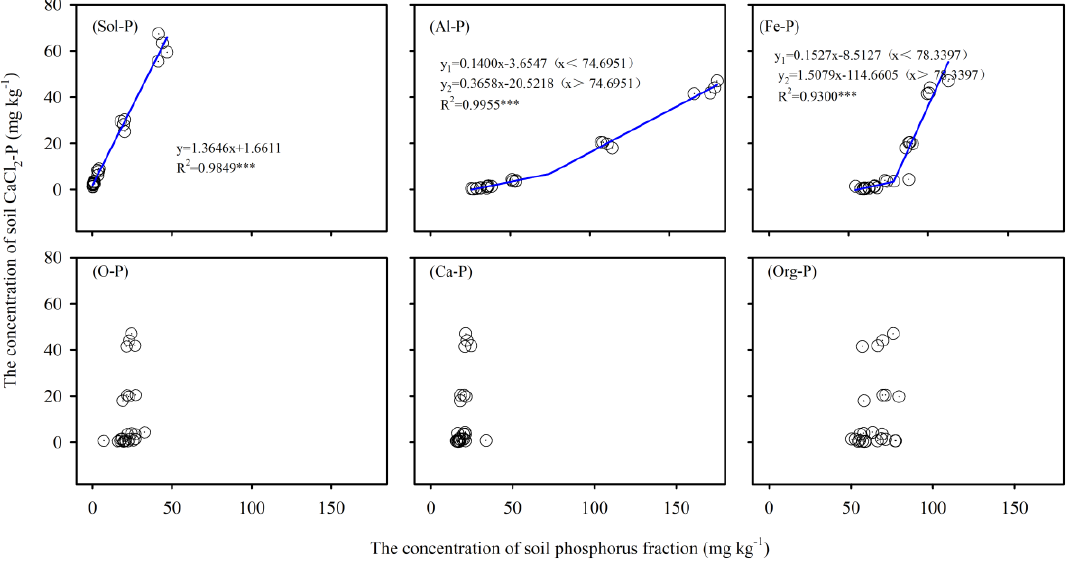
Figure 8. Relationship between soil P fraction and CaCl 2 -P come from incubation experiment. Note: *** means p < 0.001.